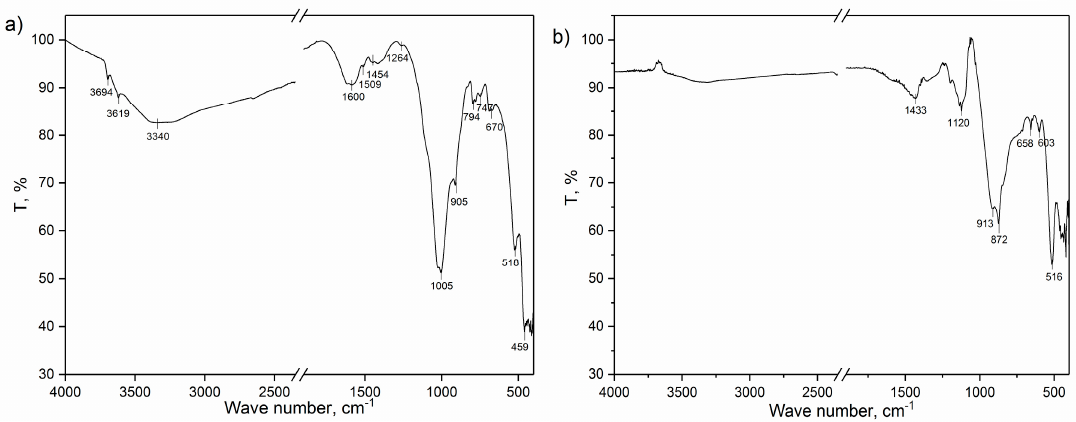
Figure 4. Infrared spectra of the: ( a ) slag and ( b ) CEM I 42.5R.